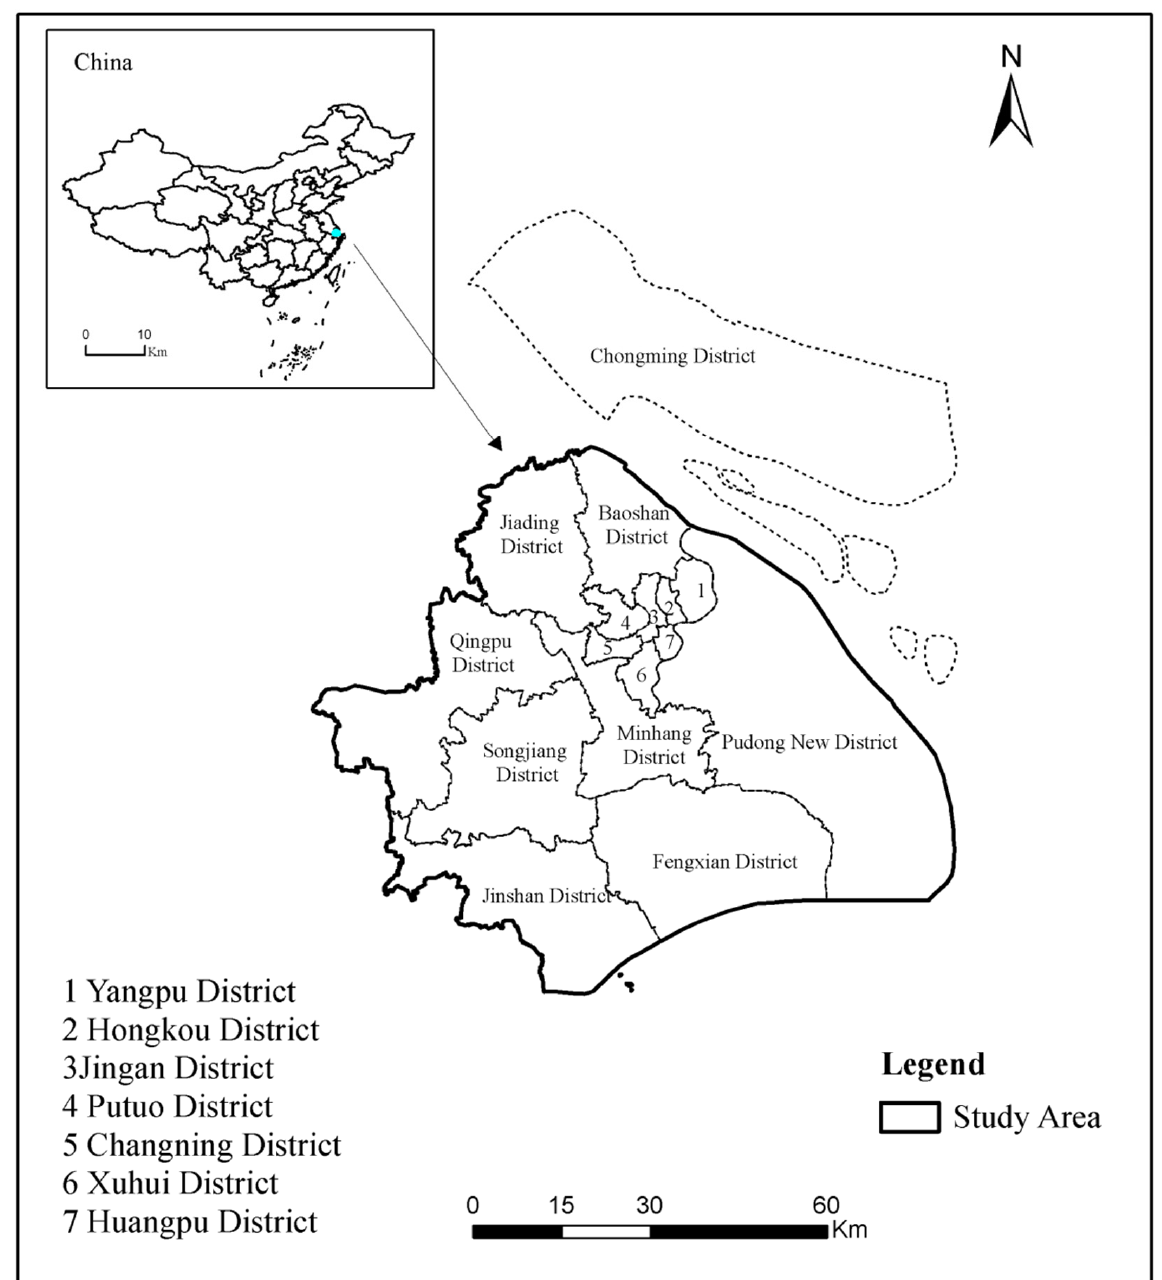
Figure 1. Regional location and district compositions of the study area. The 2017 Air Quality Index (AQI) report manifested that the average PM 2.5 concen- tration in Shanghai reached 39 µ g/m 3 [32], exceeding by 4 µ g/m 3 that of the secondary environmental air quality standards in China. The PM 2.5 was the major pollutant for 23 days in the whole year. The monthly dust-fall amount, including regional and road